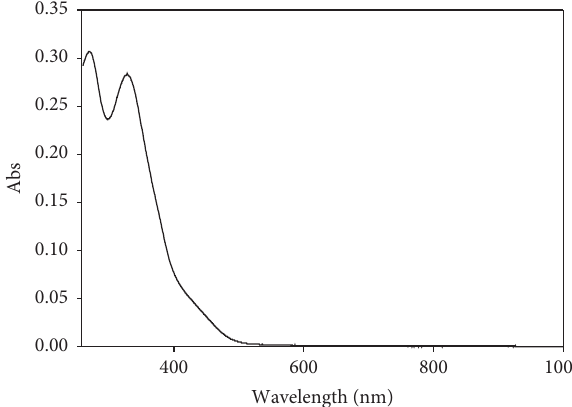
Figure 4: UV-Vis spectrum of NiL